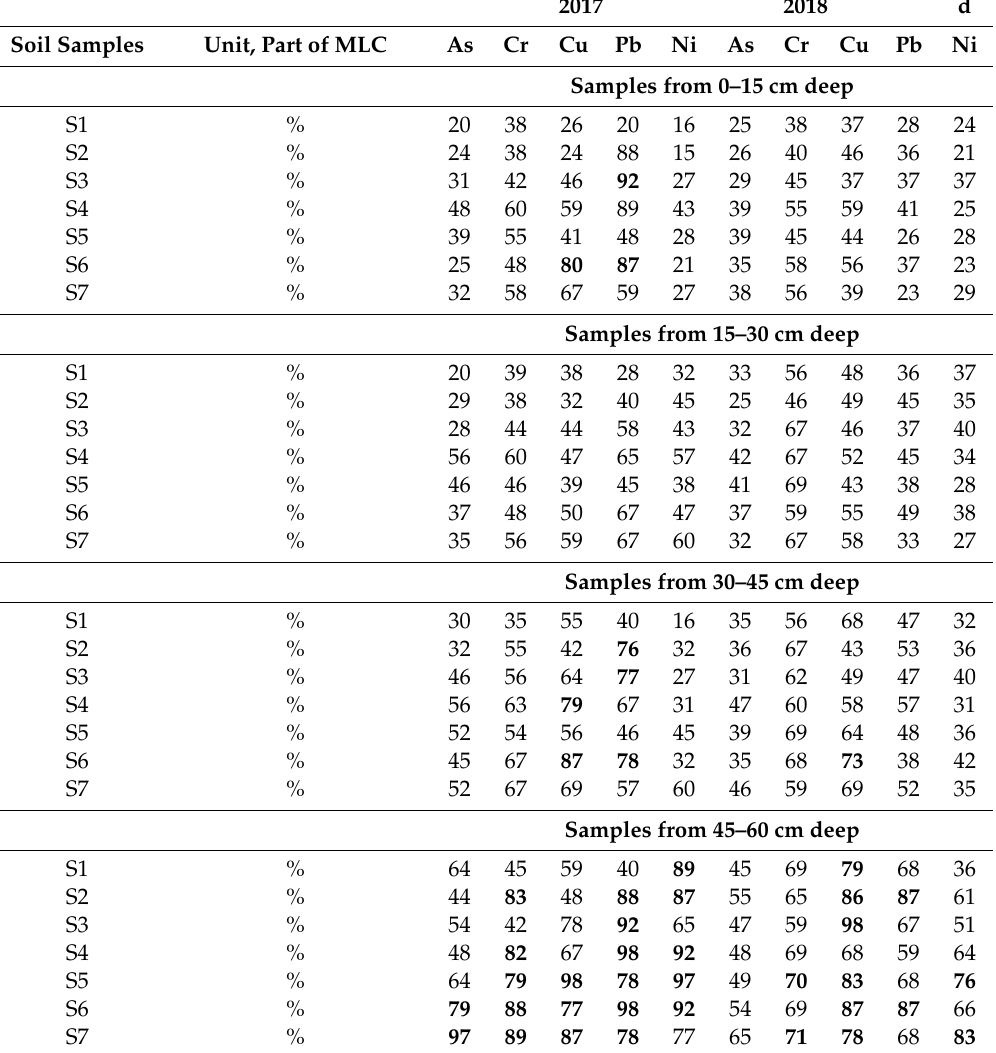
Table 2. The percentage of heavy metals and metalloid from the maximum level concentration